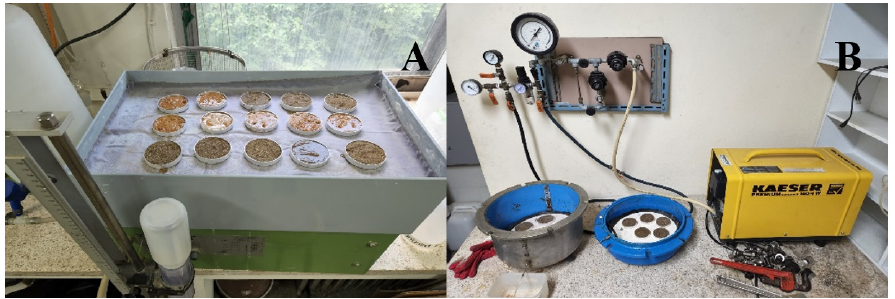
Figure 2. Photos of the sand-box ( A ) and the pressure chamber ( B ) used to measure the volume water contents. Table 3. Laboratory measured soil water contents at water potential ranging from 0 to − 1500 kPa for the five soil series.